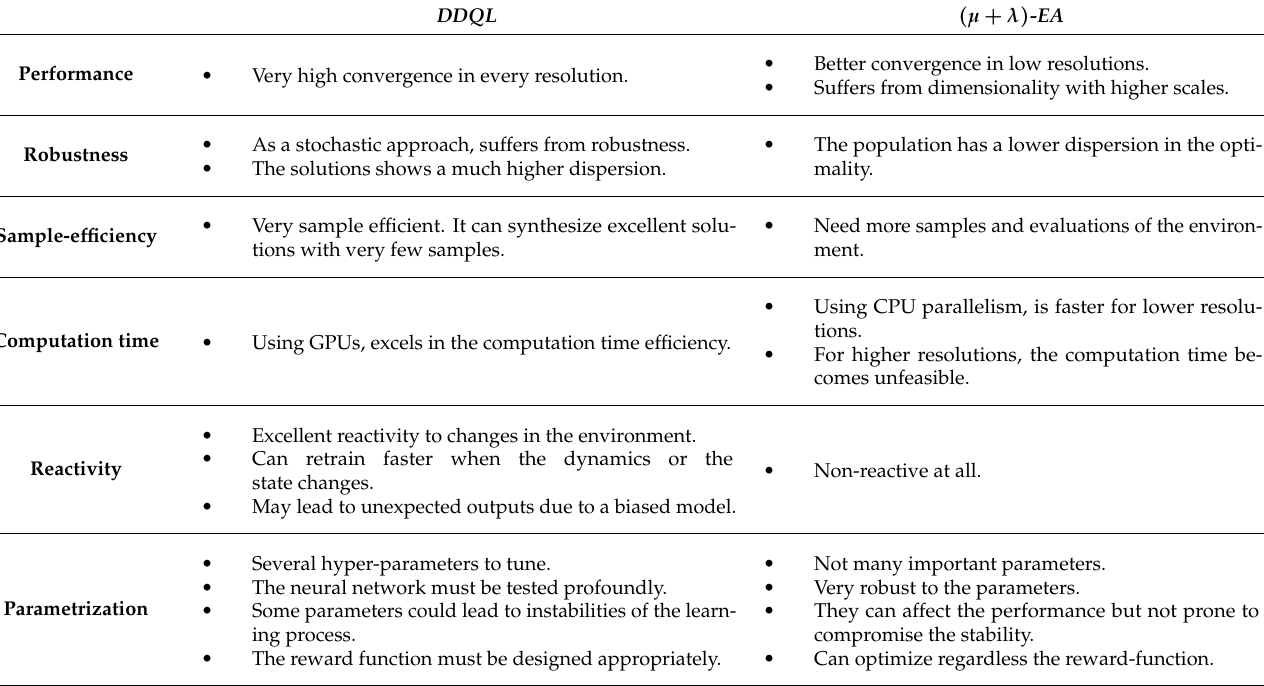
Table 10. Summary of the characteristics of DDQL and EA applied to the